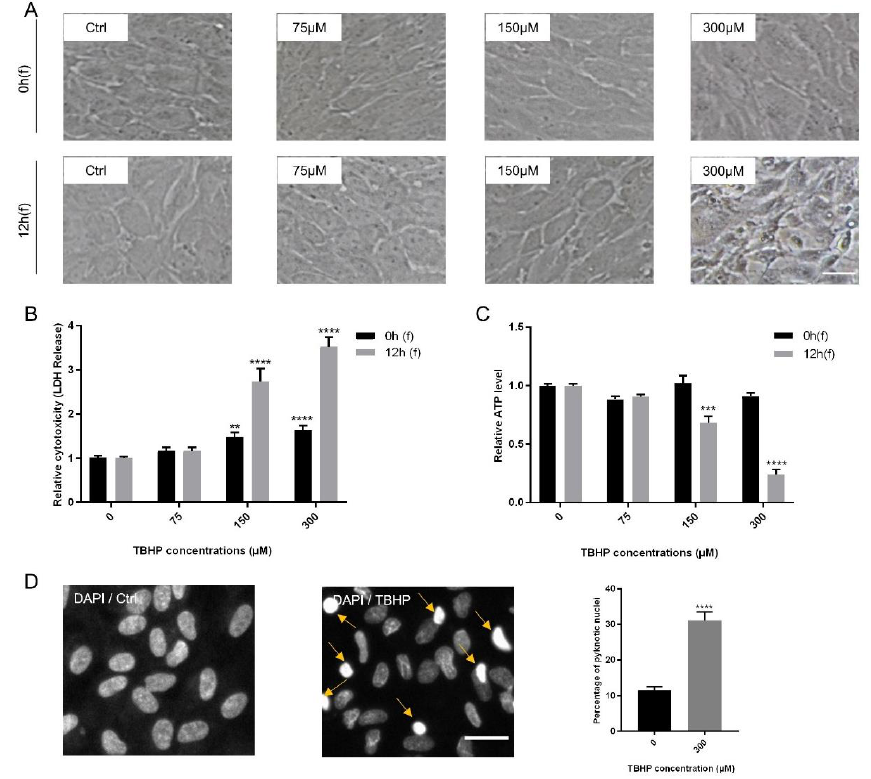
Figure 1. Modeling oxidative stress in ARPE19 cells using tert-butyl hydroperoxide (TBHP). Confluent ARPE19 cells were exposed to TBHP (0, 75, 150, or 300 µM) for 4 h. Changes in morphology of the cells ( A ), lactate de-hydrogenase (LDH) release ( B ) and intracellular ATP levels ( C ) were assessed at 0 h and 12 h following TBHP exposure (0 h(f) and 12 h(f), respectively). Severe morphological changes were obvious in cells treated with 300 µM TBHP at 12 h(f). Nuclear condensation was detected by DAPI staining and visualized and quantified by the operetta high content imaging system for the most effective TBHP concentration and following time (300 µM, 12 h(f)). Examples of condensed nuclei are shown by yellow arrows. The number of condensed nuclei are presented as percentage of total number of nuclei ( n = 4). ( D ). Data are shown as mean ± S.E.M and experiments were repeated at least three times. p -value: <0.01 (**), < 0.001 (***), < 0.0001 (****) (One-way ANOVA, Dunnett’s multiple comparison test).